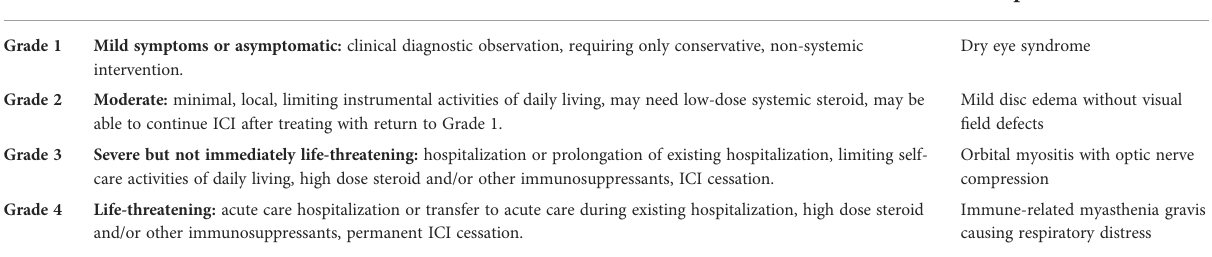
TABLE 1 Grading of immune-related adverse events with an example relevant to the neuro-ophthalmologist (17). Grade